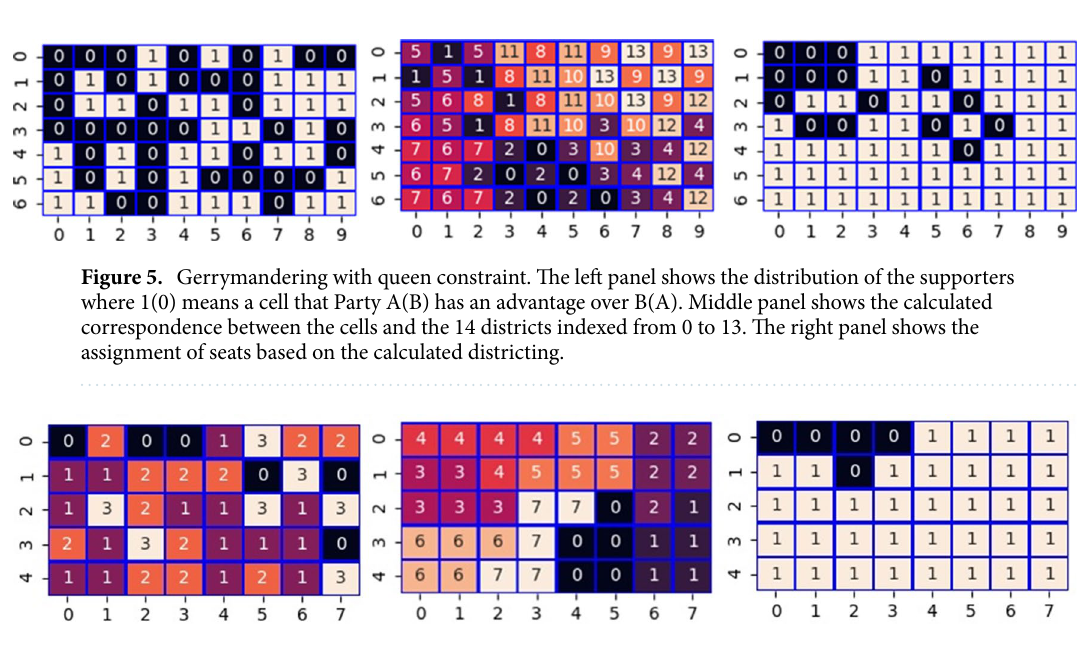
Figure 6. Gerrymandering in a multiple votes case (3 votes/cell) with rook constraint. The left panel shows the number of votes in each cell for Party A. Center panel shows the calculated correspondence between the cells and the eight districts indexed from 0 to 7. The right panel shows the assignment of seats based on the calculated